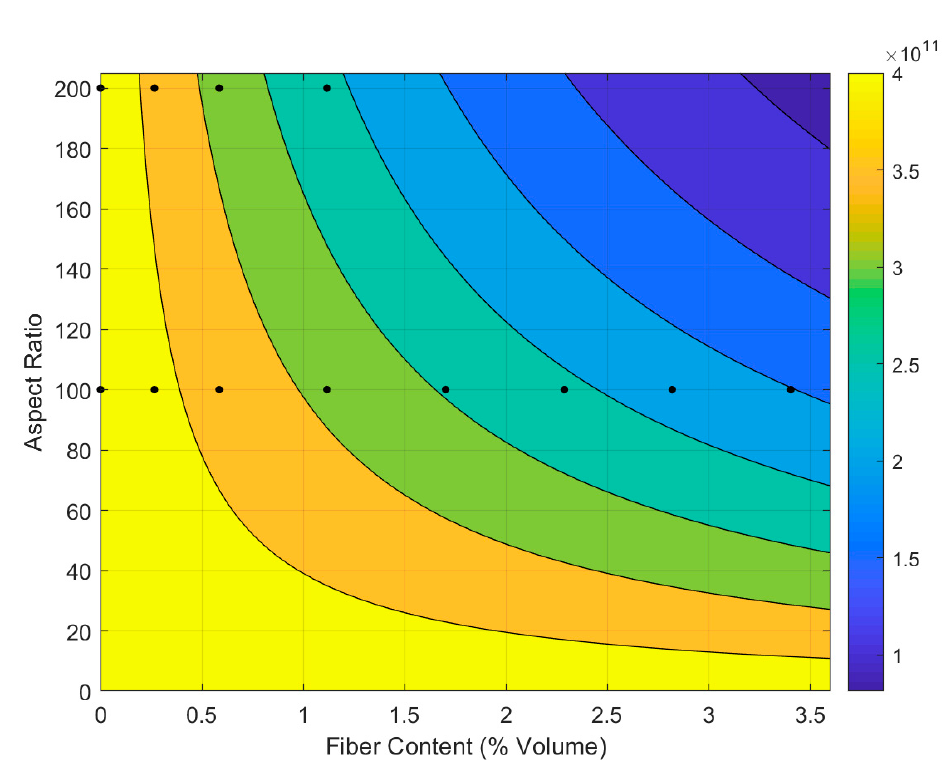
Figure 8. The surface electrical resistance ( Ω ∙ 𝑚 ) contour map for the proposed fit.